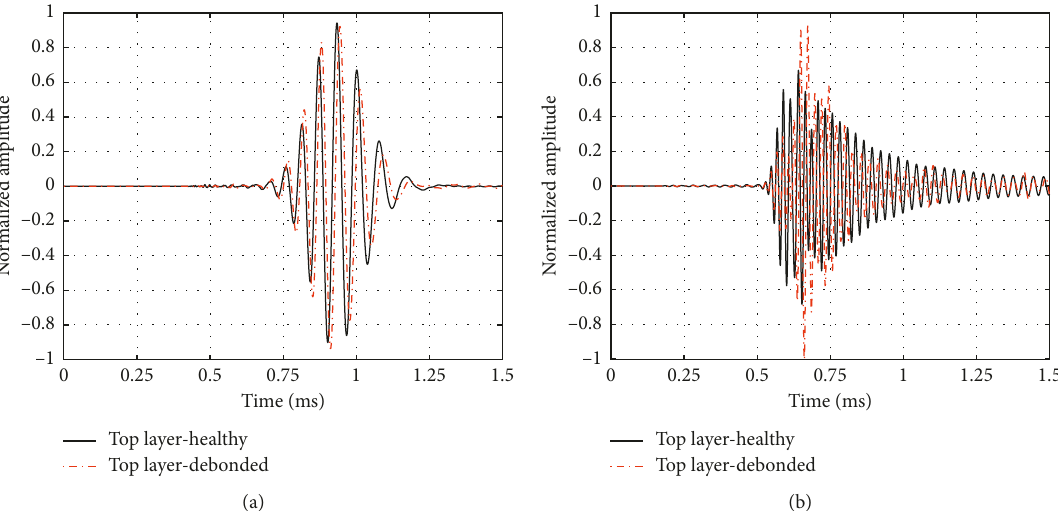
Figure 6: Response of the system in the time domain for both healthy and debonded plates for excitation frequencies of (a) 15kHz and (b) 40 kHz at a measurement node after the debonded